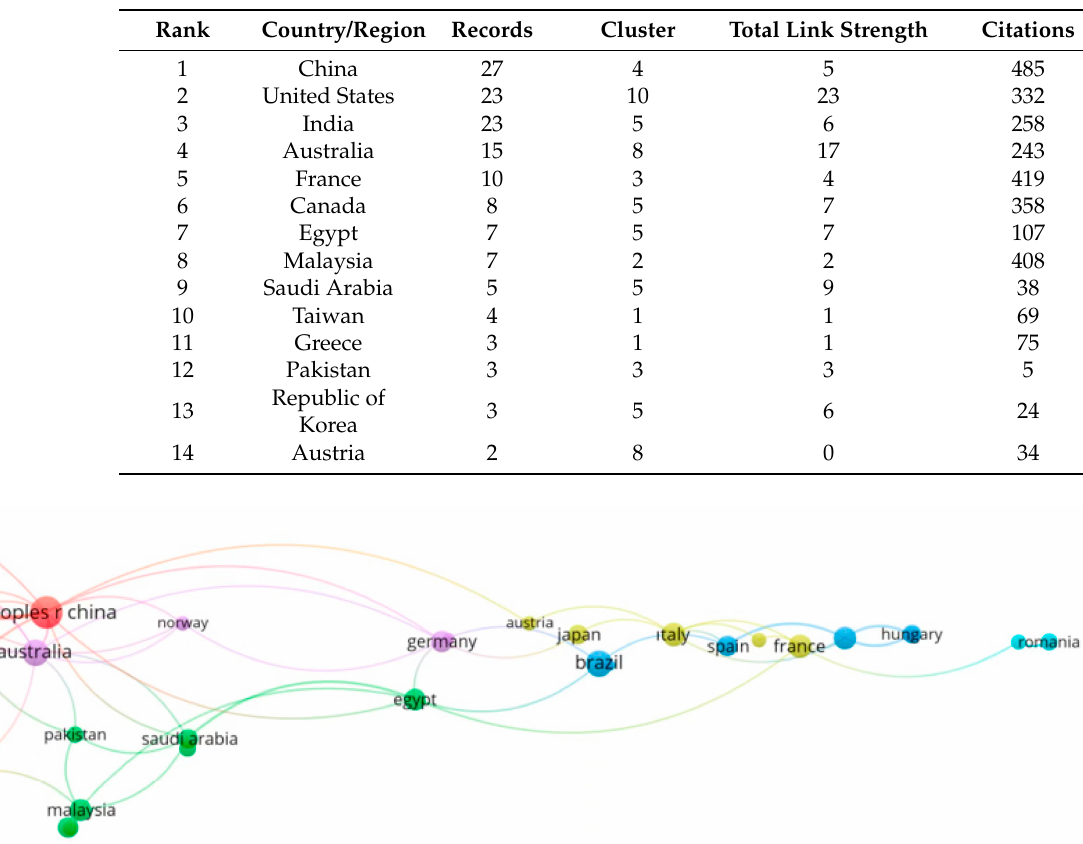
production from essential oil.